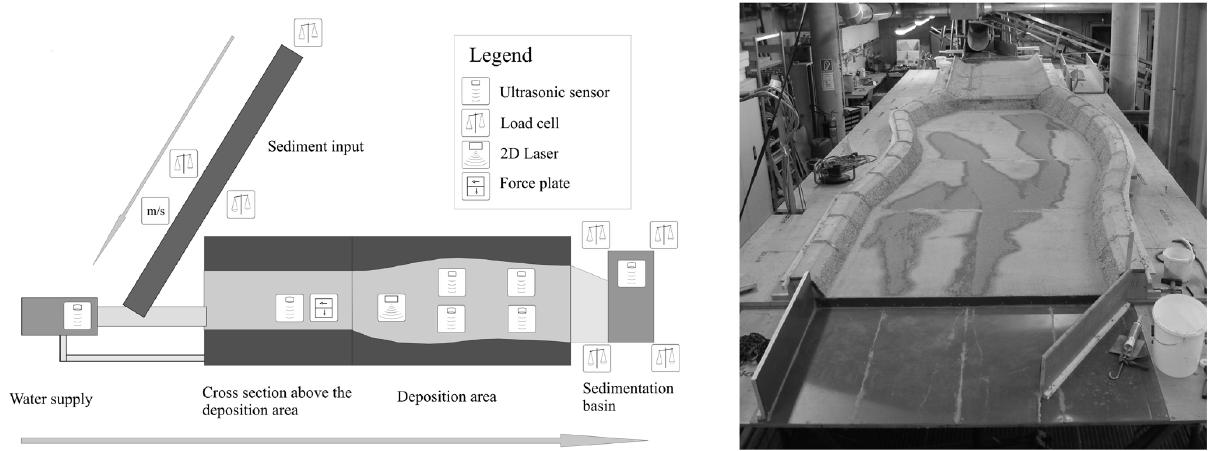
Fig. 3. Sketch (left) and picture (right) of the physical model.